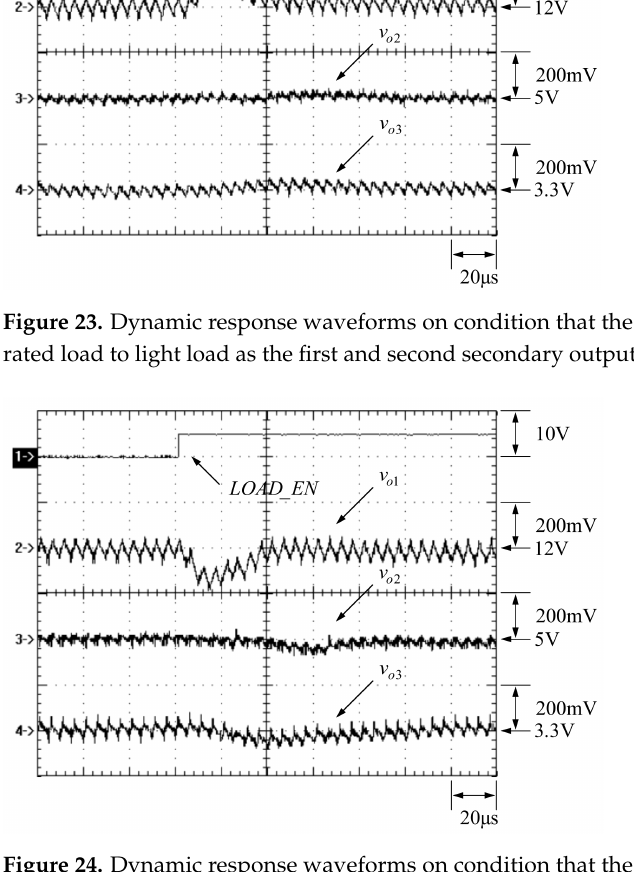
Figure 24. Dynamic response waveforms on condition that the main output load is changed from light load to rated load as the first and second secondary outputs are located at rated